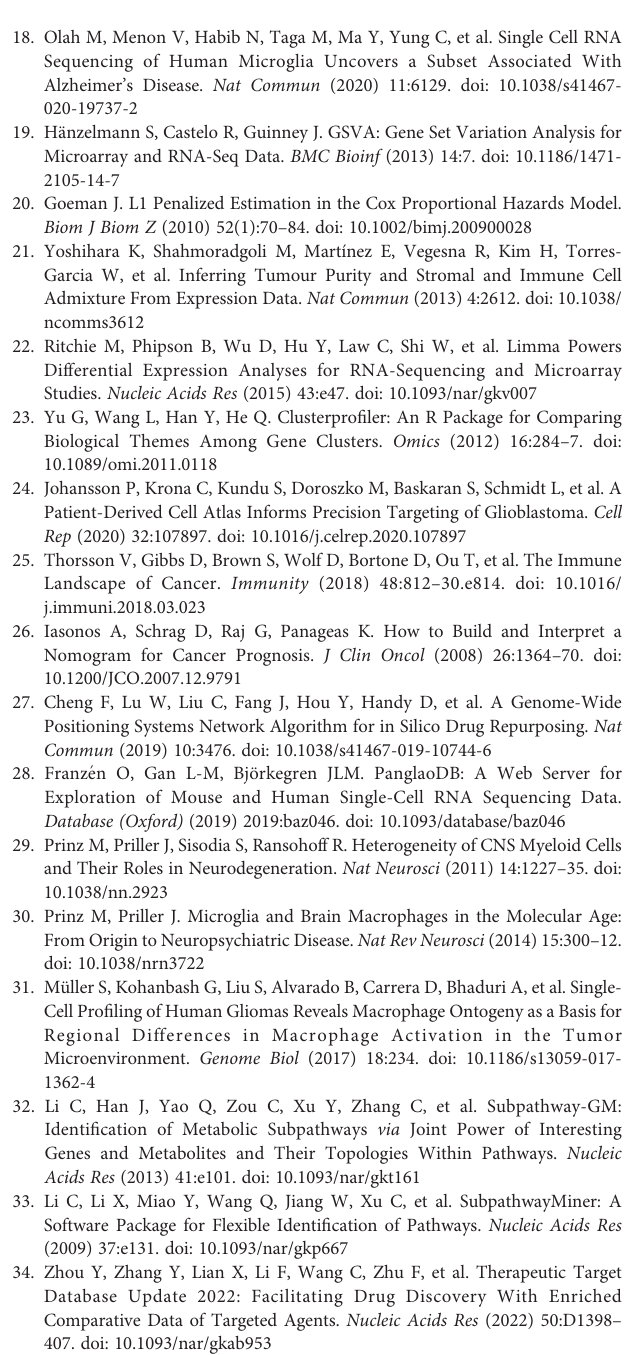
(B) The GSEA plot for GBM disease genes in the all rank genes by two GMEFS groups. Supplementary Figure 4 | The associations between GMEFS groups and therapy response in the TCGA LGG cohorts. (A) Boxplot illustrating the distribution of GMEFS for patients with different therapy responses. Signi fi cance was determined by the Wilcoxon test. (B) Bar graph illustrating the numbers of clinical responses to therapy in the high and low GMEFS groups. (C) Waterfall plot illustrating the distribution of GMEFS for patients with different therapy